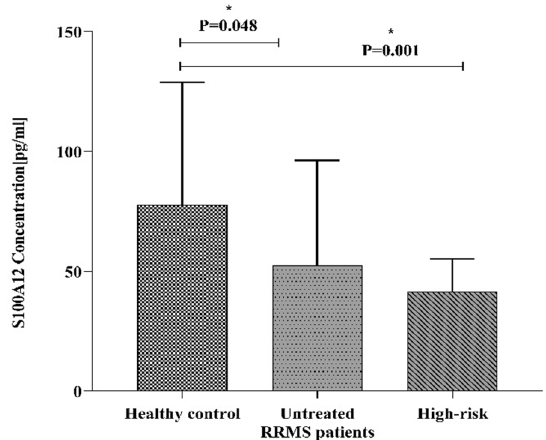
Figure 1. Represented the S100A12 concentration by mean ± SD in the different groups in three boxes. According to this chart, the concentration of S100A12 decreased significantly in two untreated RRMS and high- risk groups compared to the healthy control group ( P < 0.05).